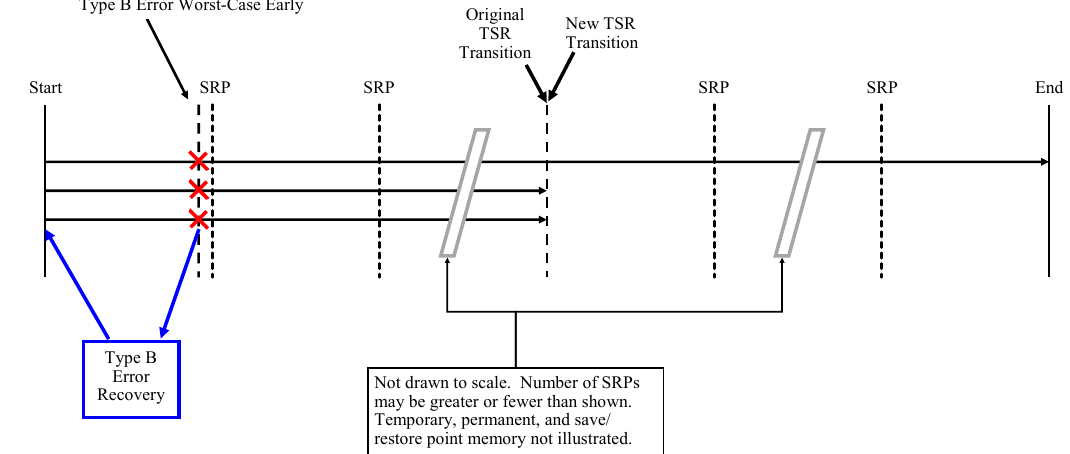
Figure A11. AHR MIPS TMR Type B Worst-Case Early error timing diagram.